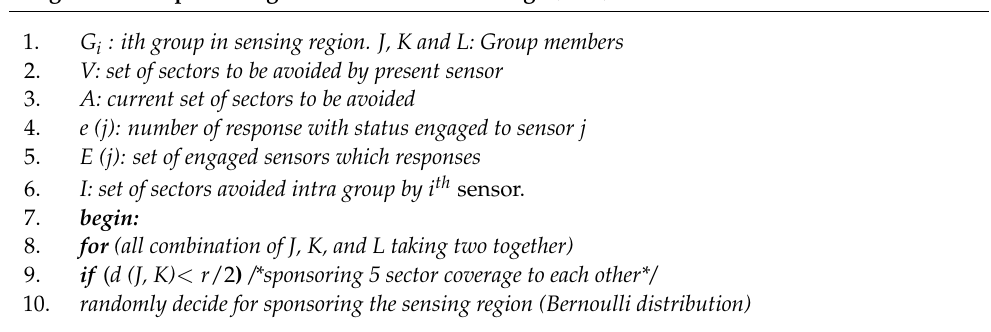
Algorithm 2: Sponsoring Aware Sectorial Coverage